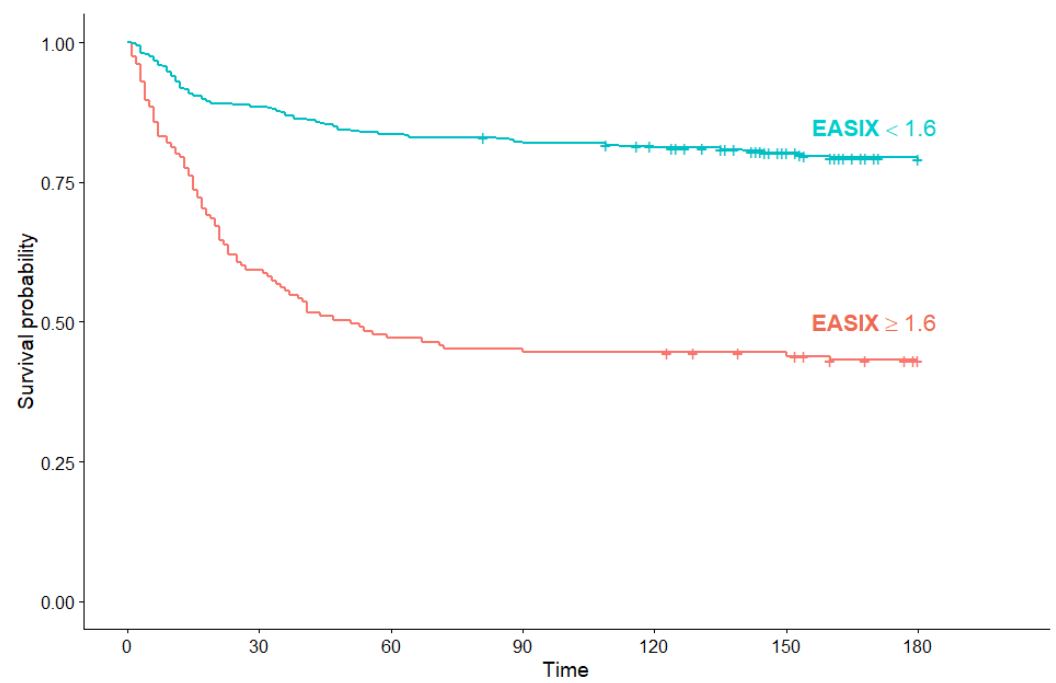
Figure 5. Kaplan–Meier survival curves for overall survival in all COVID-19 patients according to EASIX score. The prognostic value of EASIX for overall survival was validated by calculating the prediction error curve and concordance index curve (Figure 6a,b). A standardized log- rank statistic visualization is shown in Figure S1. A Kaplan–Meier survival curve for overall survival in the validation cohort of 111 hematological patients without COVID-19 according to EASIX score is shown in Figure S2.